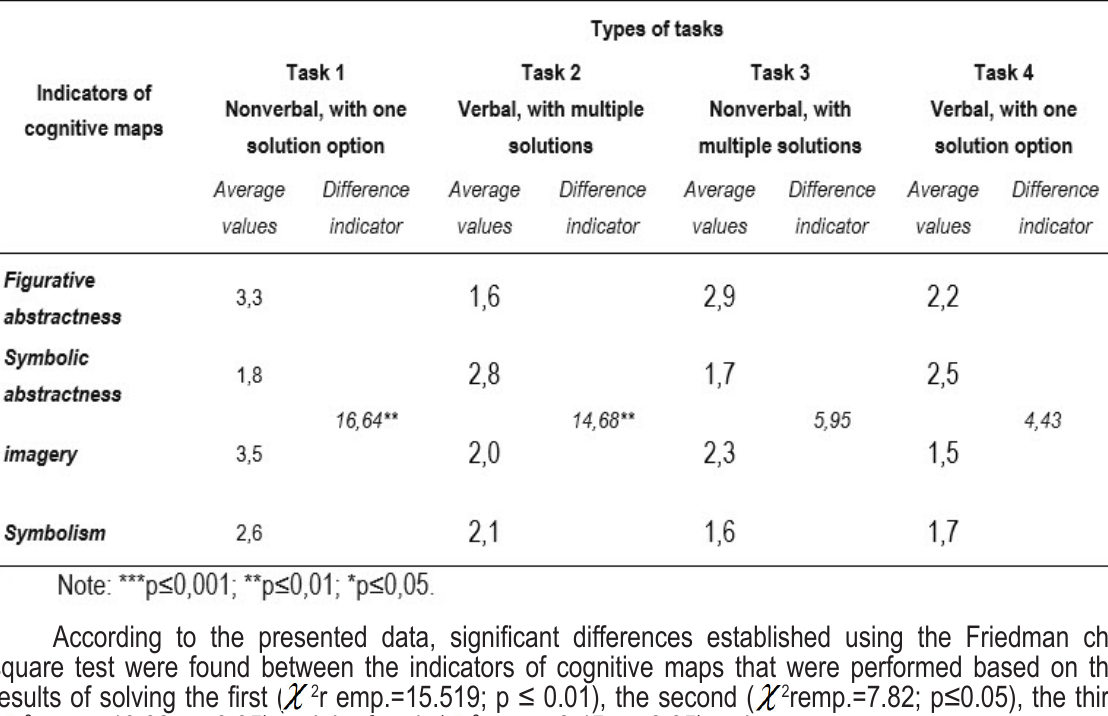
Differences between all indicators of cognitive maps performed under time constraints, based on the results of solving each individual type of